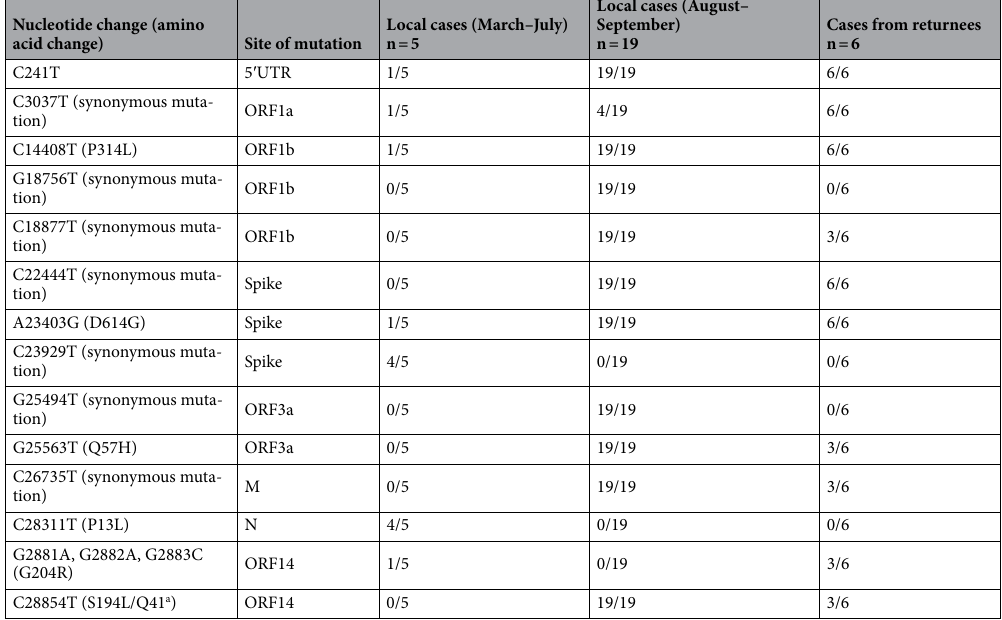
Table 1. Common mutations detected in 30 whole-genome sequences in Myanmar, 2020. ORF open reading frame, M membrane gene, N nucleocapsid protein. a Stop